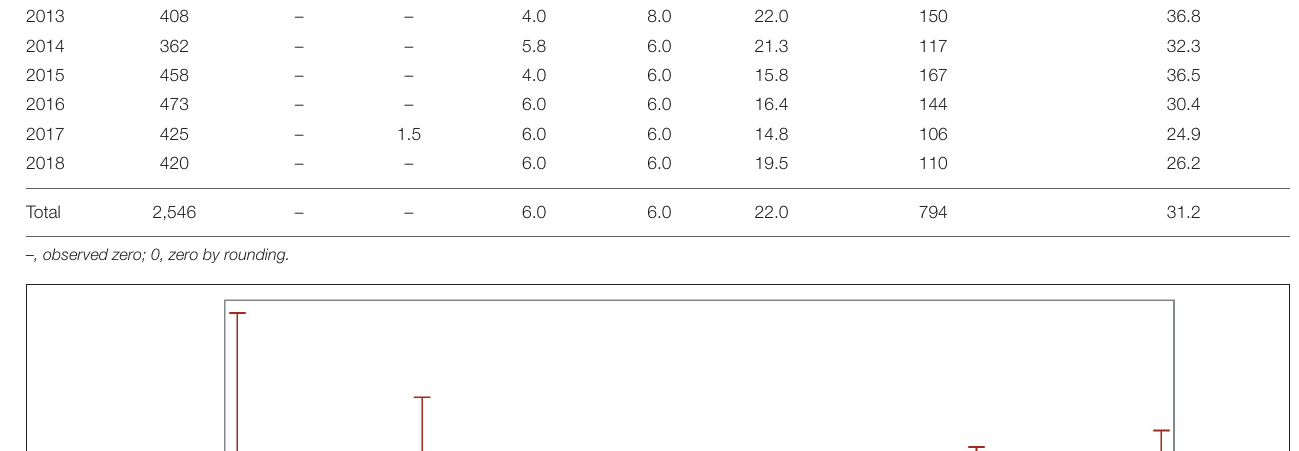
Percentage of flocks without antibiotics raised without antibiotics